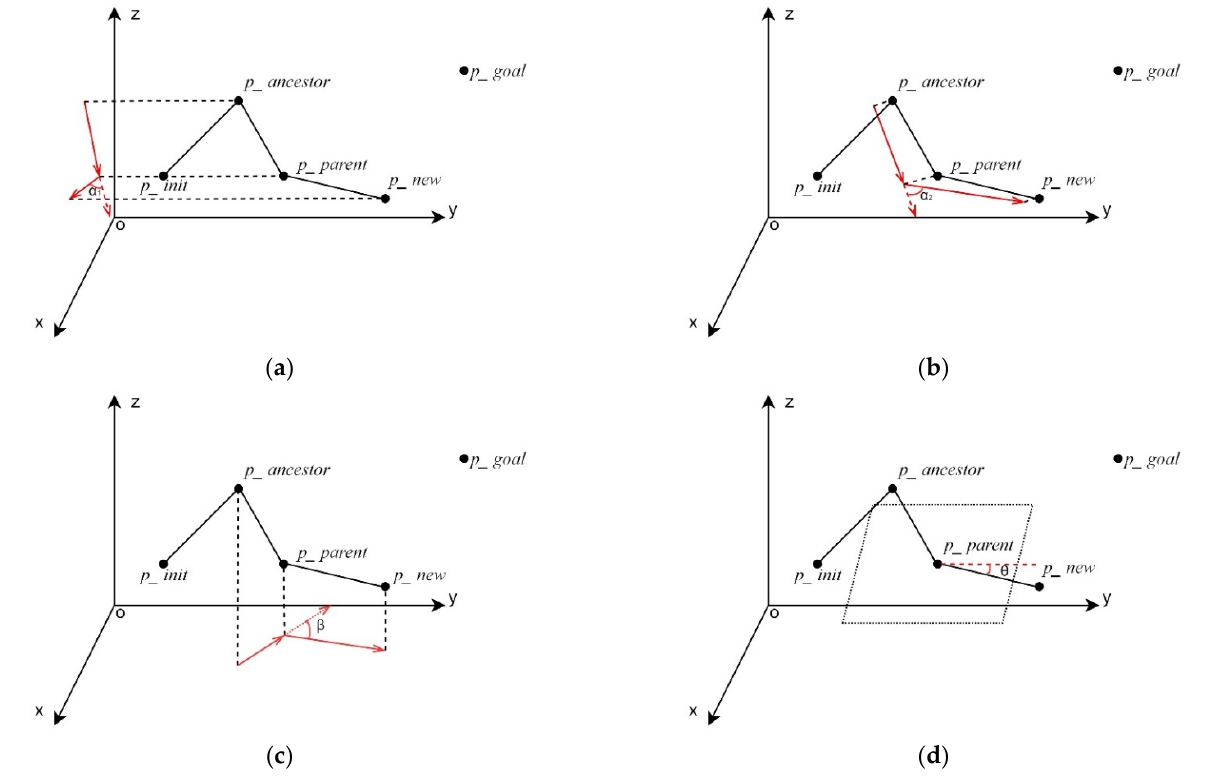
Figure 6. The projection of the angle between the vector ( _ p init , _ p new ) and the vector ( _ p init ,